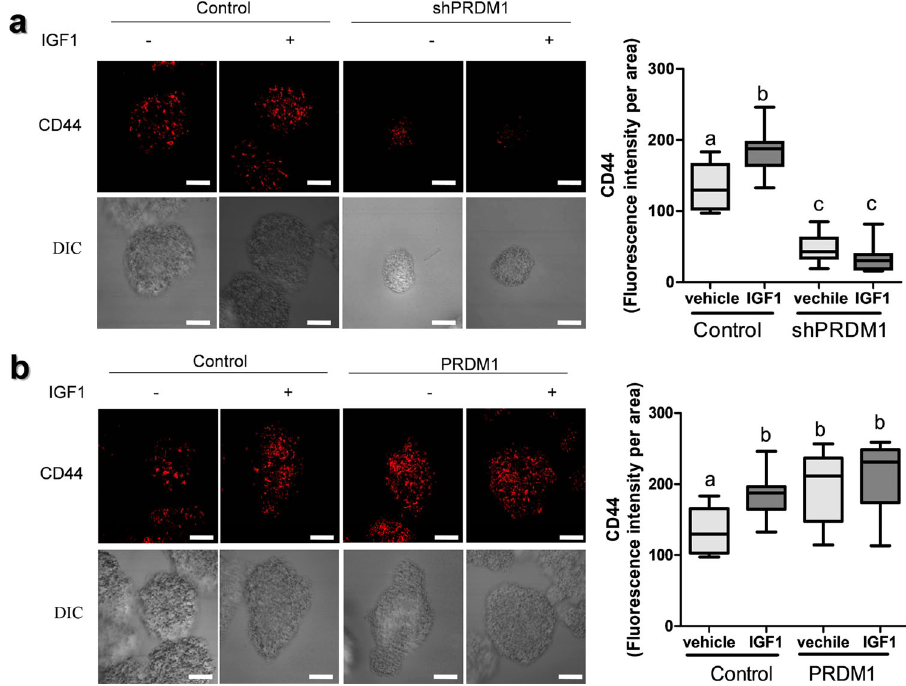
Fig. 7 Effects of PRDM1 and IGF signaling on stemness biomarkers in human CRC cell spheroids. a , b Spheroids from human CRC cells (control (the negative control shRNA ( a ) or the empty vector pMX-IRES-GFP ( b ))-, shPRDM1-expressing HCT-8 ( a ) or PRDM1-overexpressing HCT-8 ( b )) were treated with DMSO or 25 ng/ml IGF1 for 6 days, then immunostained against CD44 (red). The microscopy analysis was performed at original magni fi cation ×400; scale bar(s), 50 μ m. CD44 fl uorescence was quanti fi ed using the Image J software (the right graphs). Results are shown as a plot with Tukey whiskers and different letters (a – c) over each box represent signi fi cant differences between groups ( n = 10, P <